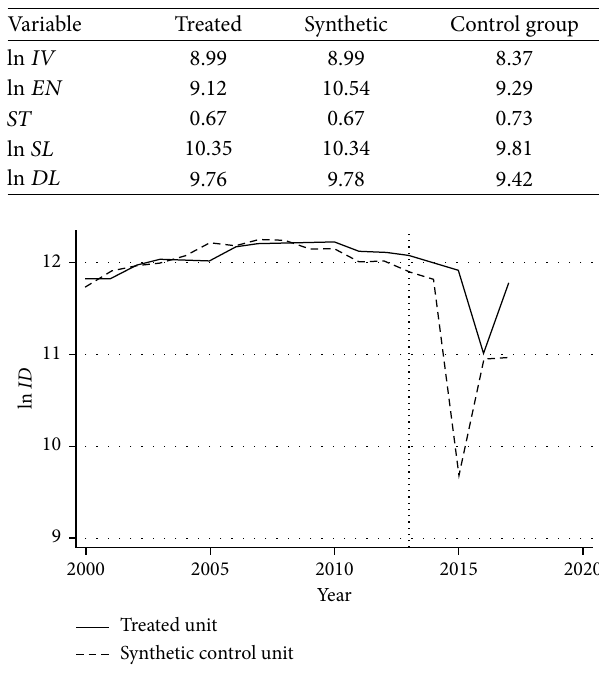
Figure 2: Comparison of industrial sewage discharges between “real Zhejiang” and “synthetic